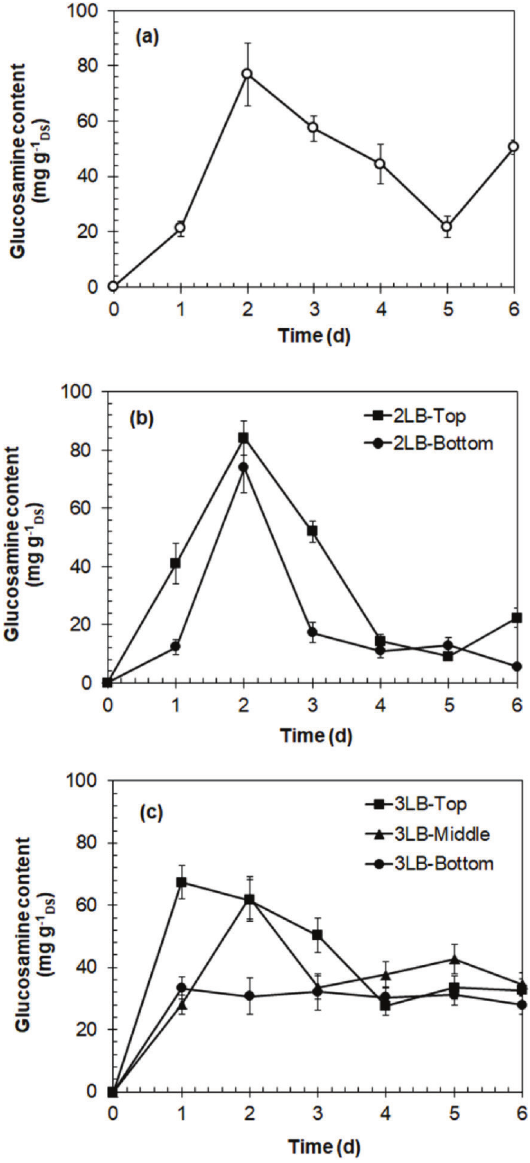
Fig. 4 – Moisture contents of fermented substrate (a) control packed-bed bioreactor, cB; (b) Two-layered packed-bed biore - actor, 2lB; (c) Three-layered packed-bed bioreactor,